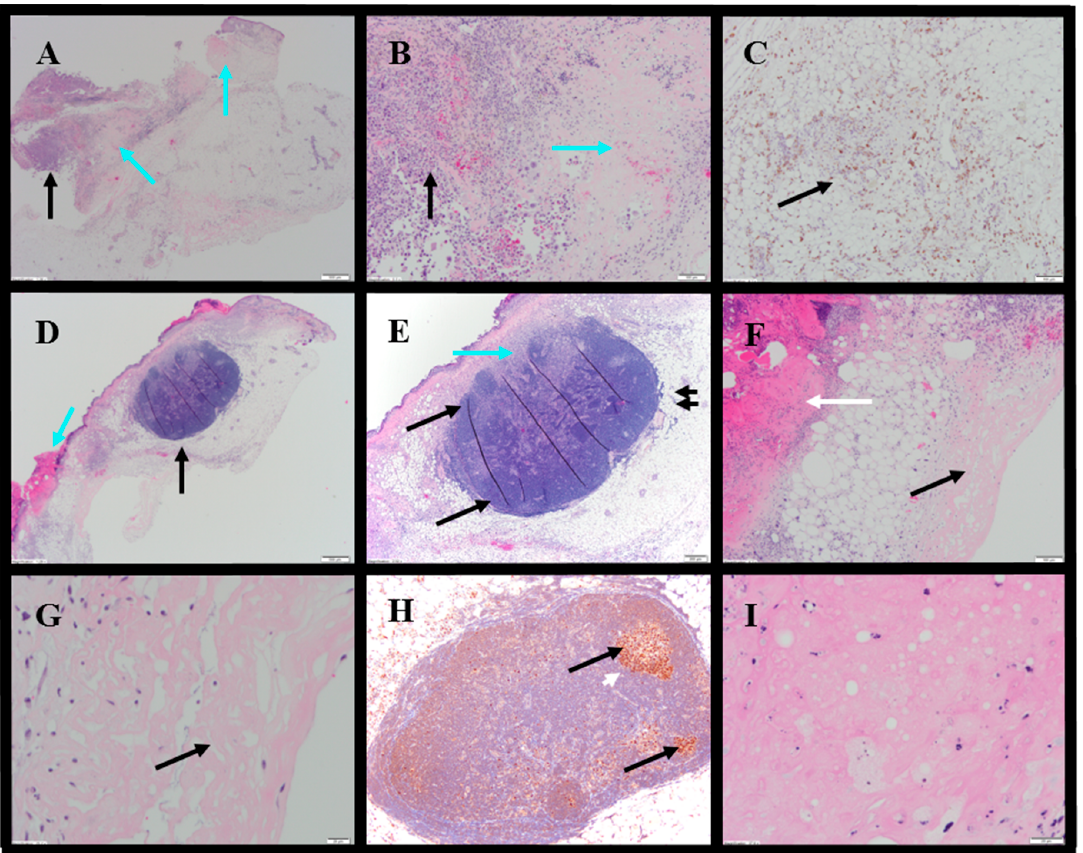
Figure 8. Representative photomicrographs of bladder tumors. Row 1: 1× IT NanoDoce ® . ( A ) H&E: extensive TCN (blue arrows). Focal viable carcinoma measuring 2.5 mm (black arrow) 2×. ( B ) Extensive TCN in panel A —viable TCs (black arrow) and necrosis (blue arrow) 10×. ( C ) Anti-CD68 shows mild macrophage infiltrate (black arrow) in the surrounding fatty tissue 10×. Row 2: 2× IT NanoDoce ® . ( D ) Skin ulceration (blue arrow) with underlying necrosis. A lymphoid structure (LS (black arrow)) 2×. ( E ) LS: discrete demarcation from the surrounding fat (double black arrows). LS organization includes a hilar region that contains sinuses (blue arrow) and lymphoid follicles (black arrows) 4×. ( F ) Same as in D —ulcerated skin at left (white arrow), necrotic tissue at right (black arrow) 10×. Row 3: ( G ) Necrotic area in panel F shows homogenous amorphous necrotic material with no viable TCs 40×. ( H ) 3× IT NanoDoce ® : Anti-BCL6 shows LS containing lymphoid follicles composed of BCL6 + germinal centers (black arrows) surrounded by mantle zone B-cells that do not express BCL6 (white arrow) 10×. ( I ) 3× IT NanoDoce ® : Area of amorphous necrotic material with no viable TCs 60×.